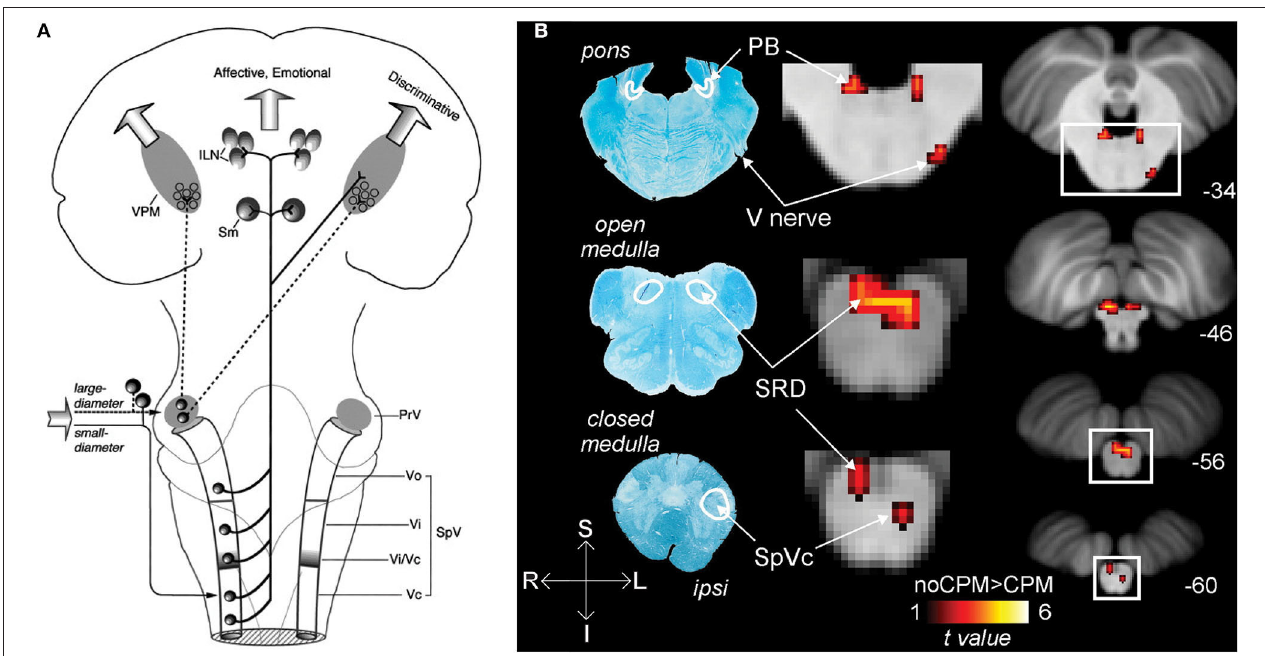
FIGURE 1 | Nociceptive pathways. (A) The path of afferent signal transmission from the periphery to the cortex through major projections of the trigeminothalamic pathway. Reprinted/adapted by permission from Springer Nature Customer Service Centre GmbH: Springer Nature Trigeminothalamic Tract Projections. In: Schmidt R., Willis W. (eds) Encyclopedia of Pain by Ke Ren, Copyright (2007). DOI: https://doi.org/10.1007/978-3-642-28753-4_4626. (B) Decreased brainstem fMRI activity, including PB, during endogenous analgesia. Red/yellow indicates regions where fMRI responses to noxious stimuli demonstrated a signal decrease following conditioned pain modulation. Decreased activation was noted in the SRD, SpVc, and the trigeminal nerve along with the PB. On the left, myelin-stained sections are displayed alongside corresponding MRI images of the brainstem. Reprinted from NeuroImage, Vol 124(Part A), AM Youssef, VG Macefield, LA Henderson, Pain inhibits pain; human brainstem mechanisms, p54–62, Copyright (2020), with permission from Elsevier. DOI: https://doi.org/10.1016/j.neuroimage.2015.08.060. PrV, principal sensory nucleus; SpV, spinal trigeminal nucleus; Vo, subnuclei oralis; Vi, subnucleus interpolaris; Vc, subnucleus caudalis; PB, parabrachial nucleus; SRD, subnucleus reticularis dorsalis; SpVc, spinal trigeminal nucleus caudalis; V, trigeminal nerve; Compas: S, superior; I, inferior; R, right; L,